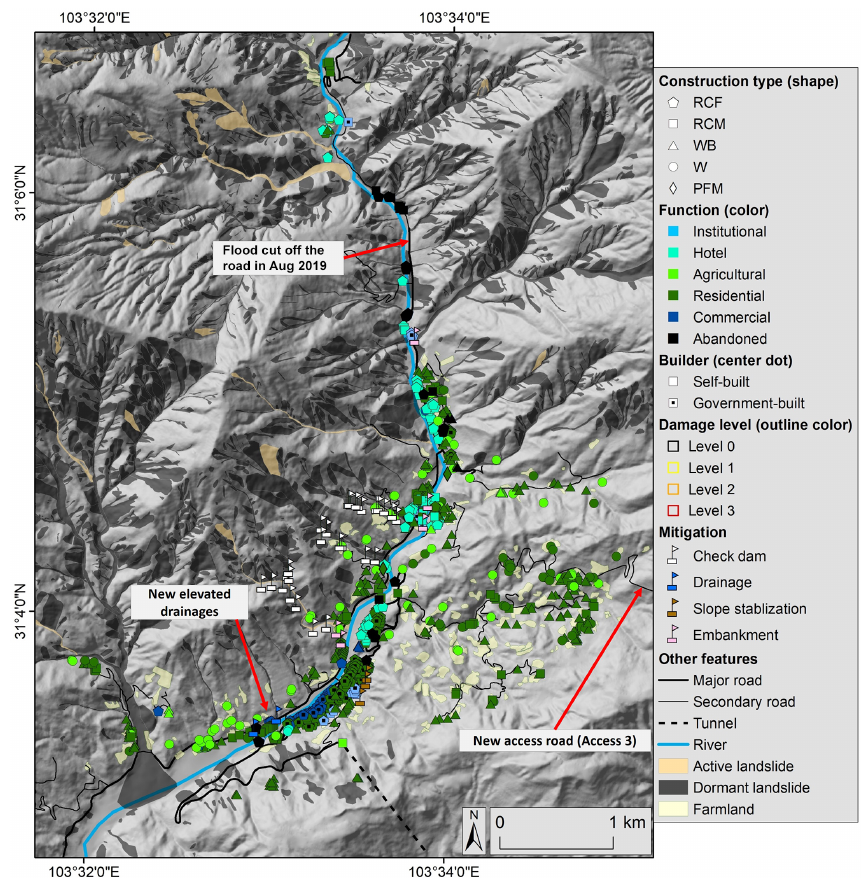
Figure 10. The inventory made based on the 2018 Pléiades image, overlaid with landslide polygons made based on the standards of Tang et al. (2016). The location of the last reported disaster, where a flood cut off the dirt road in the north on 20 August 2019, is